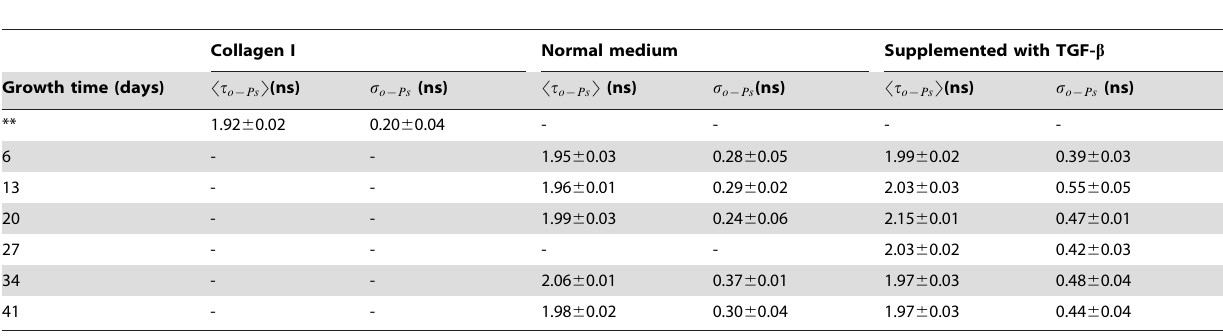
Table 1. o -Ps mean lifetime ( S t o { Ps T , ns) and distribution ( s o { Ps , ns) in collagen I and T84 human colonic adenocarcinoma three- dimensional cell cultures grown in normal conditions and with TGF- b , at different growth time points.